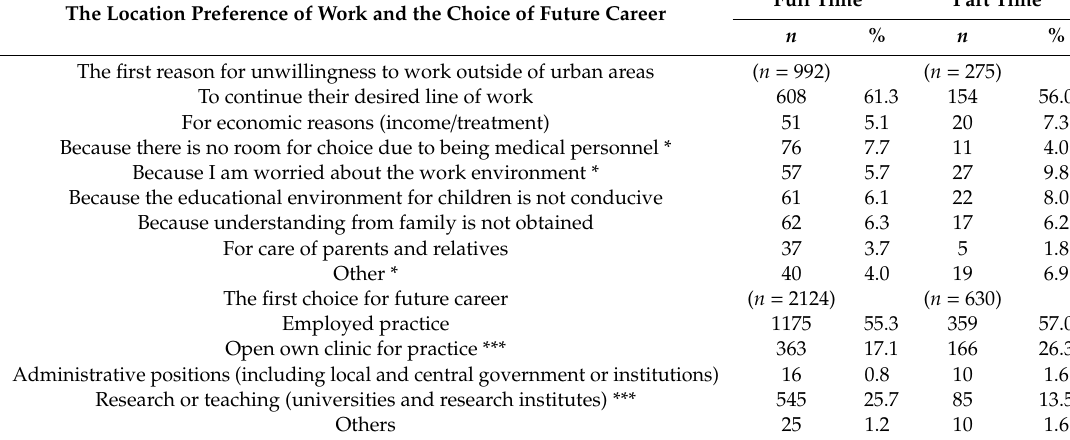
Table 3. The location preference of work and the choice of future career among full-time and part-time